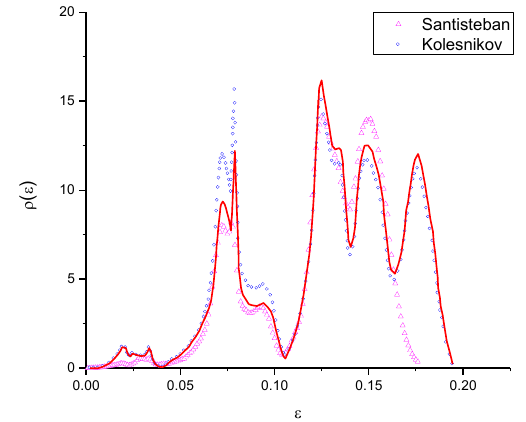
Fig. 7 : Adopted density of states for MgH 2 (solid line), compared with the experimental results (symbols) of Refs.[23] and [24].